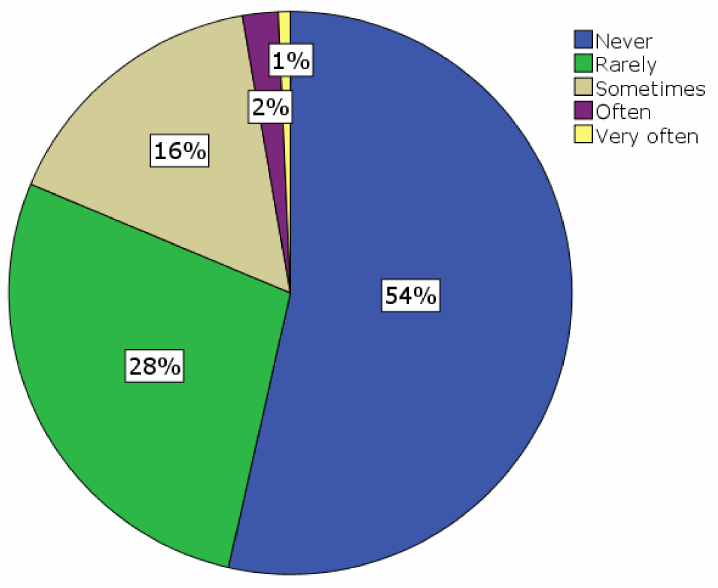
Figure 9. How often does feeling unsafe or vulnerable prevent you from walking in